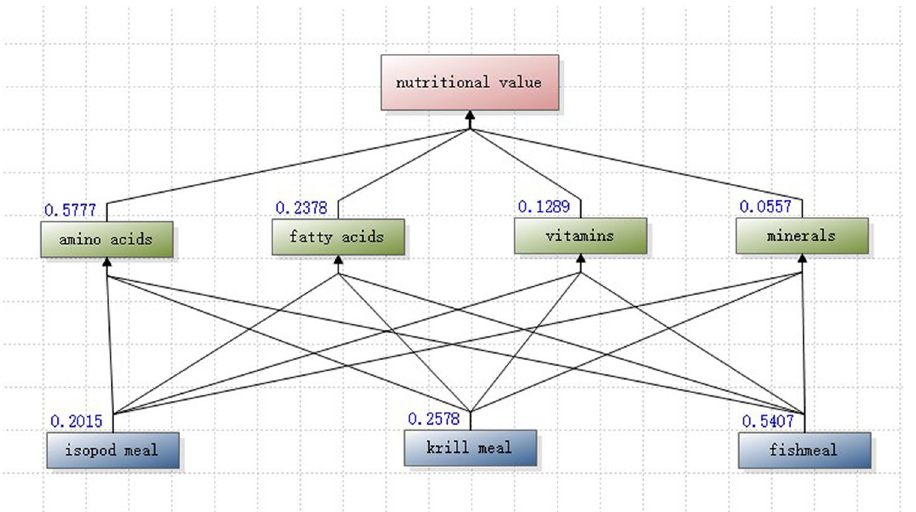
Figure 5. Nutritional value of three substrates based on group decision analytic hierarchy process of experts’ judgement. The larger the blue numbers, the greater the importance of the index. It was computed and generated with software YAAHP (Yet Another Analytical Hierarchy Process, https:// www. metad ecsn. com/ yaahp/). Version 10.0, Shanxi Meta-Decision Software Technology Co. Ltd,